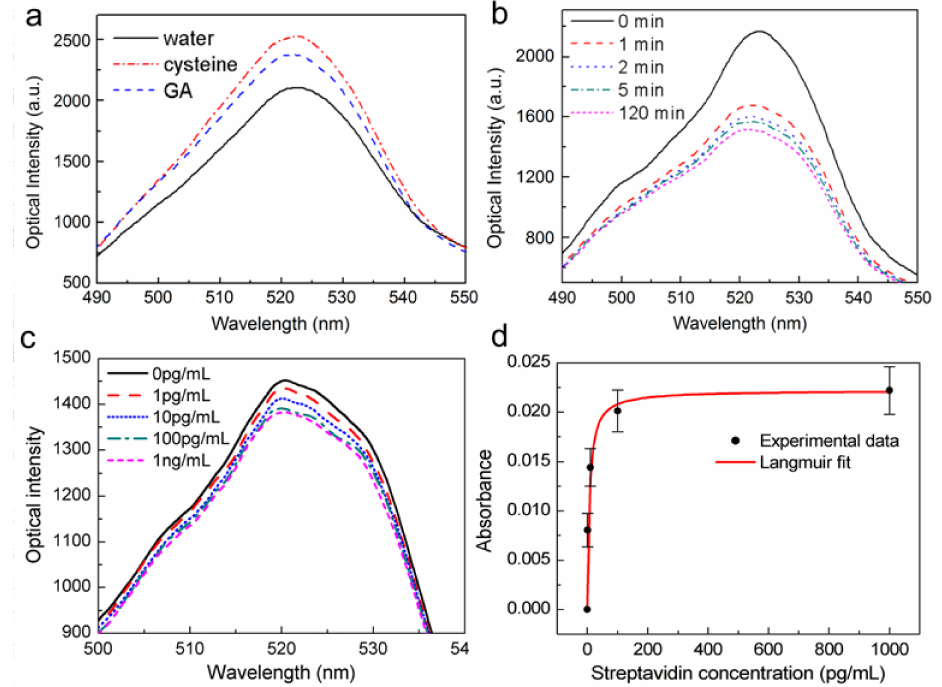
Figure 6. Spectral responses ( a ) after each step of gold nanoparticle surface functionalization; ( b ) during the immobilization process of biotinylated BSA; ( c ) to streptavidin with different concentrations; ( d ) Experimental results and Langmuir